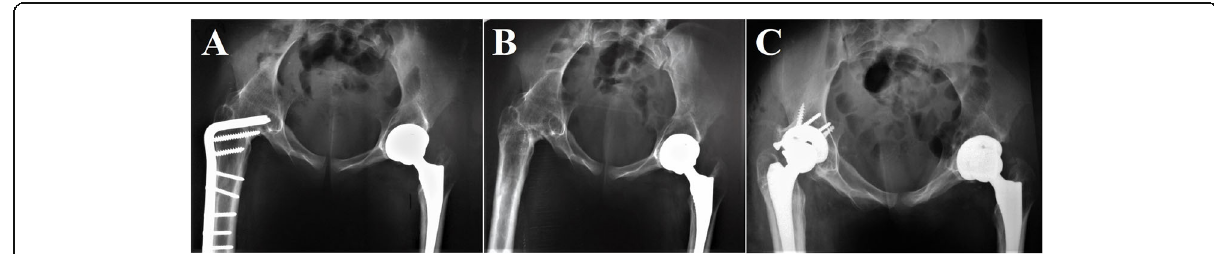
Fig. 2 Stages of hip reconstruction surgery. a Union of the right subtrochanteric fracture and THA of the left hip. b Removal of the right CBP as a first stage for right hip THA. c THA of the right hip with acetabulum reconstruction